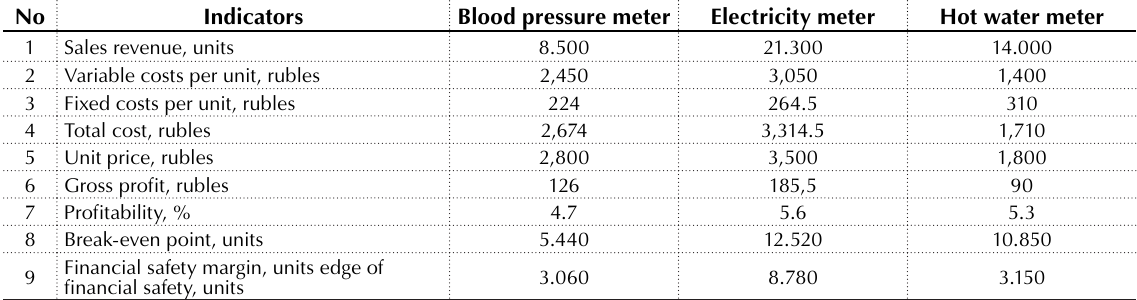
Table 3. Calculation of indicators necessary to develop the commodities assortment manufactured by the